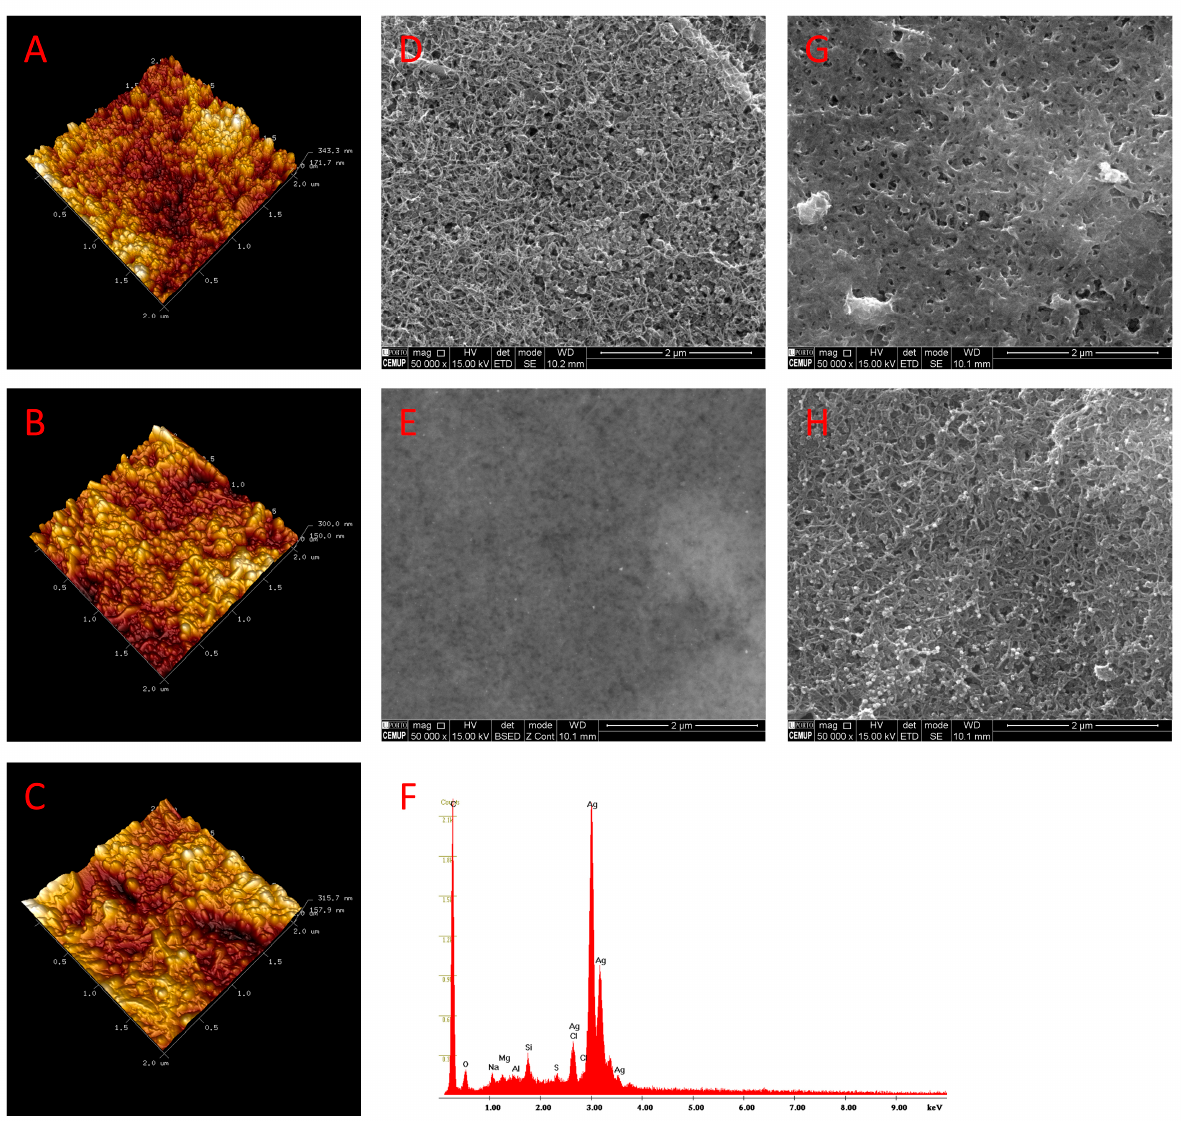
Figure 3. AFM images of bare-SPCE ( A ), SPCE-MWCNT-AgNP ( B ), and SPCE-MWCNT-AgNP-MIP ( C ); SEM images (50,000 magnification) of SPCE-MWCNT ( D ), SPCE-MWCNT-AgNP ( E ), SPCE-MWCNT-AgNP-MIP after polymerization ( G ), and SPCE-MWCNT-AgNP-MIP after extraction ( H ); EDS analysis of SPCE-MWCNT-AgNP ( F ).